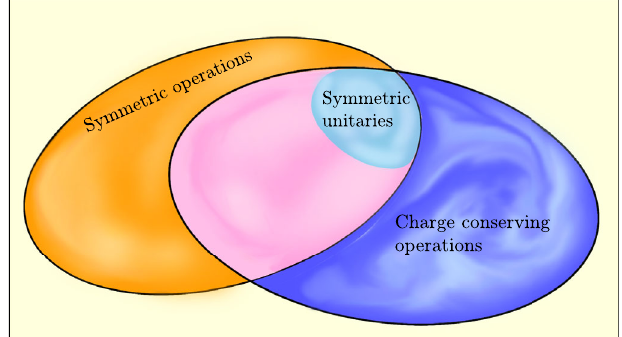
FIG. 1. Disconnect between symmetries and conservation laws for open quantum dynamics. Every continuous symmetry of the closed unitary evolution implies a conserved charge, but under the same symmetry constraints, quantum channels may change the expectation value of such